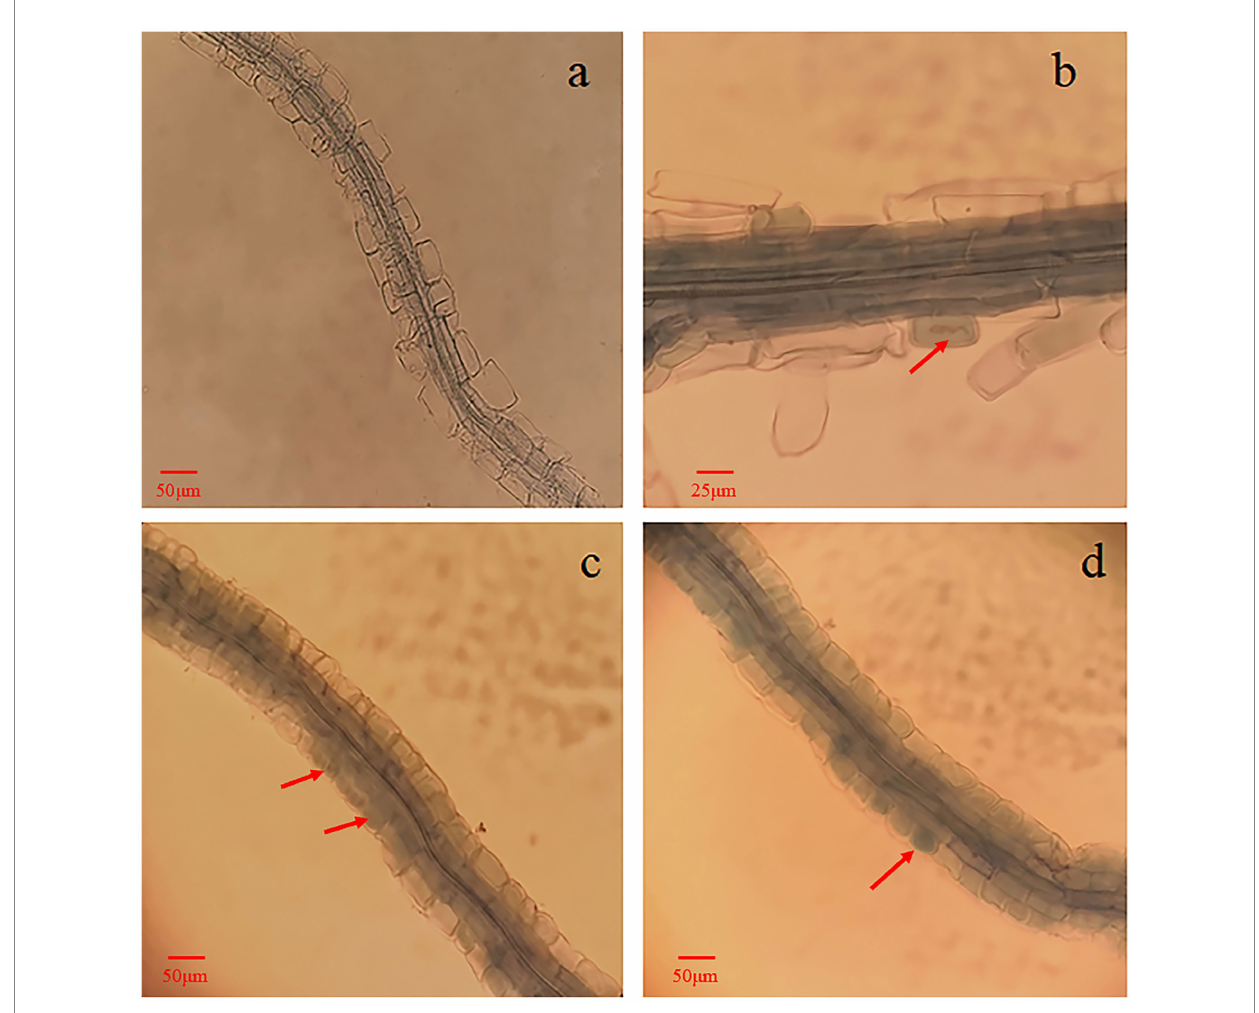
FIGURE 3 Microscopic observation of blueberry roots inoculated with O. maius 143. (A) Blueberry alone, roots of control seedlings (without inoculation) with no mycorrhizal colonization. (B) Blueberry with the mycorrhizal fungus O. maius 143. (C) Blueberry with the mycorrhizal fungus O. maius 143 and L6 isolates. (D) Blueberry with the mycorrhizal fungus O. maius 143 and LM3 isolate. Hyphal growth inside the epidermal cells of roots from inoculated plants is shown in B , C , and D . The red arrows are mycelial